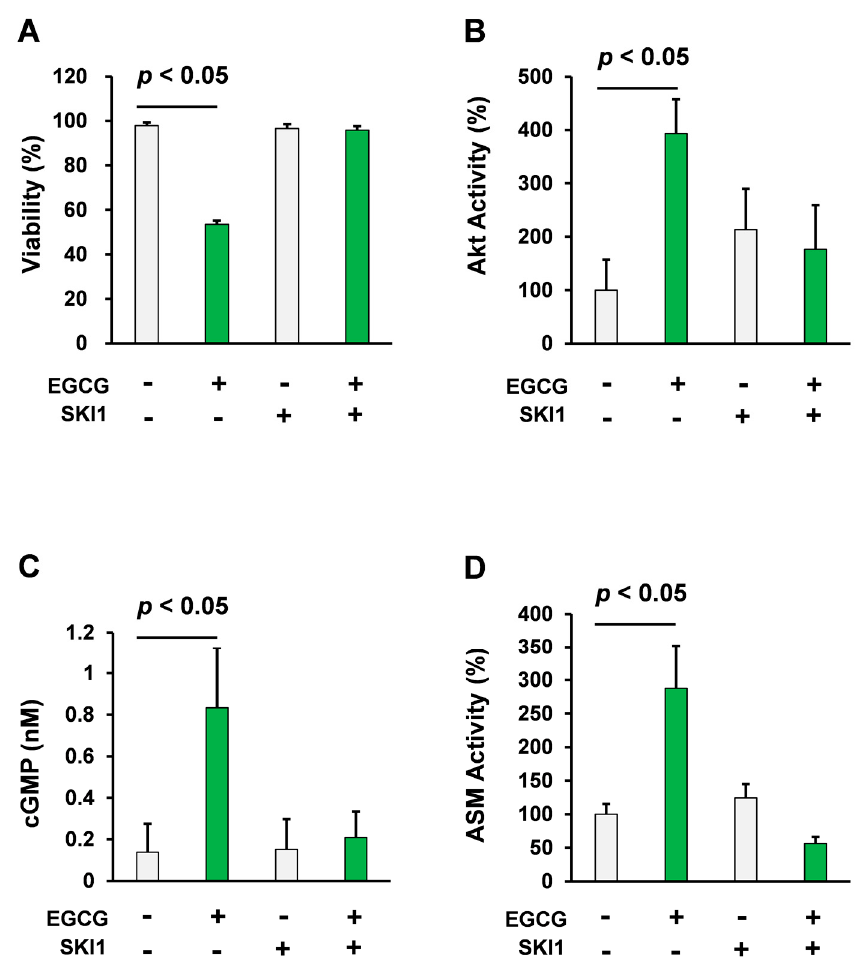
Figure 1. Pharmacological inhibition of Src attenuated the cell death inducing effect of EGCG. ( A ) U266 human multiple myeloma cells were treated with EGCG (10 μ M) and SKI1 (2.5 μ M, from 1 h before EGCG treatment) for 72 h. Cell viability was measured using the trypan blue method ( n = 4). ( B ) U266 human multiple myeloma cells were treated with EGCG (10 μ M) and SKI1 (2.5 μ M; from 1 h before EGCG treatment) for 1 h. Akt activity was evaluated using the K-LISA kit ( n = 4). ( C ) U266 human multiple myeloma cells were treated with EGCG (10 μ M) and SKI1 (2.5 μ M; from 1 h before EGCG treatment) for 3 h. cGMP levels were evaluated using competitive immunoassay ( n = 4). ( D ) U266 human multiple myeloma cells were treated with EGCG (10 μ M) and SKI1 (2.5 μ M; from 1 h before EGCG treatment) for 3 h and ASM activity was evaluated ( n = 3).